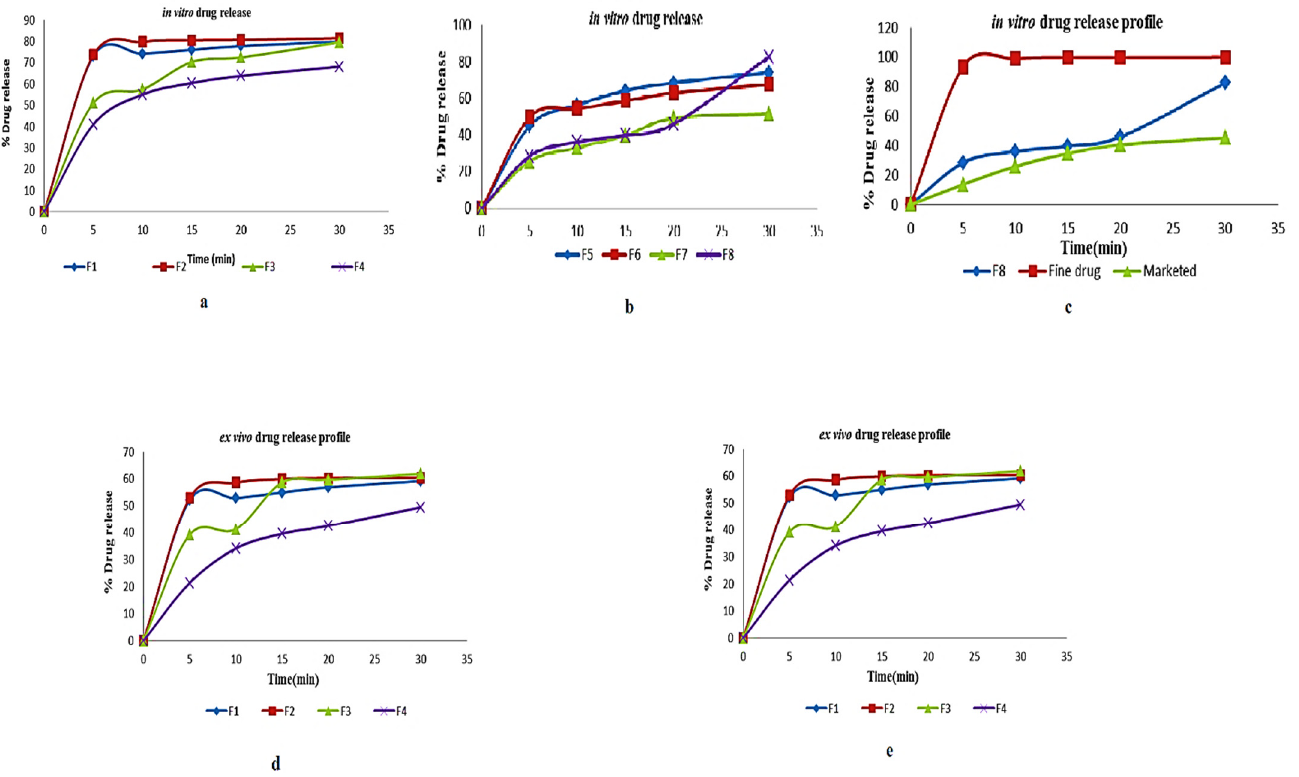
Figure 30. ( a , b ) In vitro drug release of synthesized hydrophilic polymer–gel in various formulations; ( c ) in vitro drug release of synthesized hydrophilic polymer–gel in the marketed product formulation; and ( d , e ) ex vivo drug release profile of developed gels in different formulations. Reproduced with permission from [333].